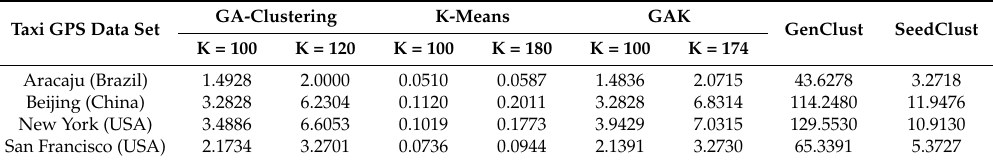
Table 6. The average computational times (in minutes) of the clustering algorithms for four taxi GPS data sets. Taxi GPS Data Set